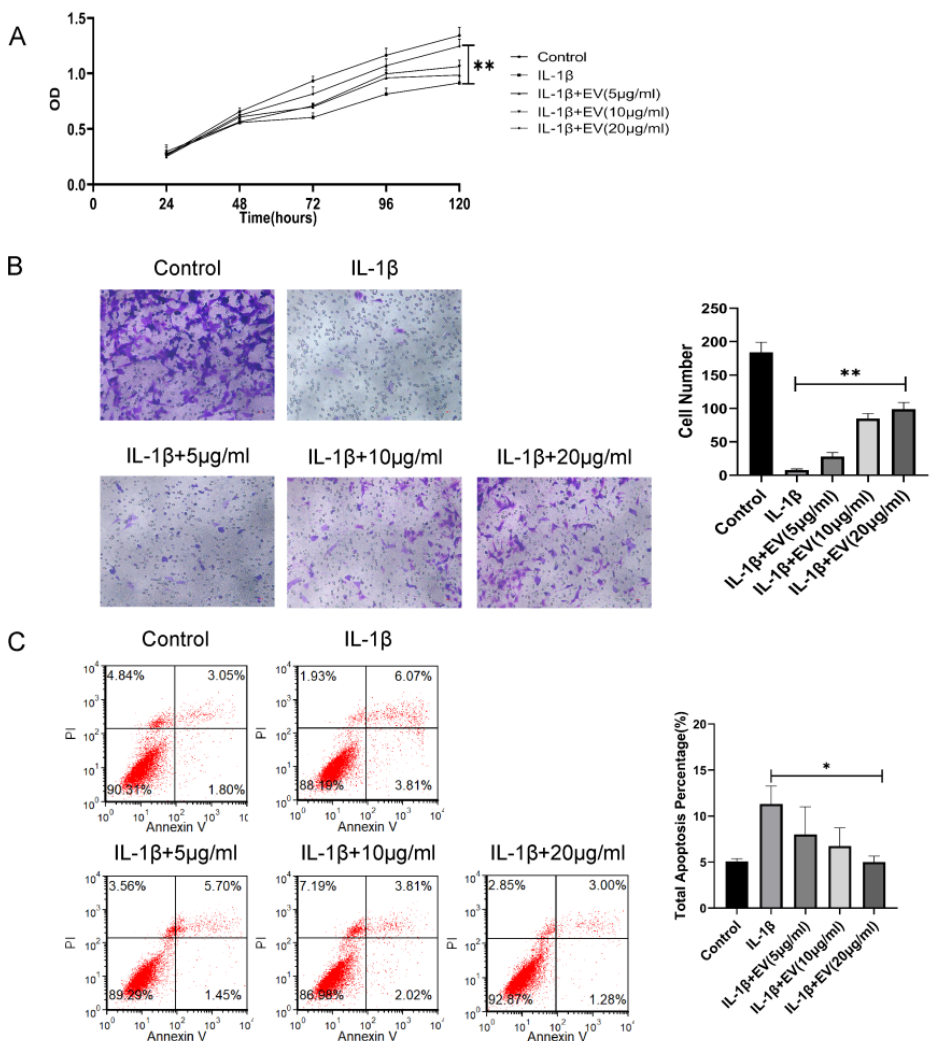
Figure 2. BMSC-EVs attenuated the proliferation and migration and inhibited the apoptosis of inflammatory chondrocytes. ( A ) The proliferation of chondrocytes was evaluated by CCK-8 assay. ( B ) Chondrocyte migration was determined by the Transwell migration assay (Scale bar = 50 µ m). ( C ) Flow cytometry was used to analyze apoptosis in inflammatory chondrocytes. * p < 0.05, ** p < 0.01.